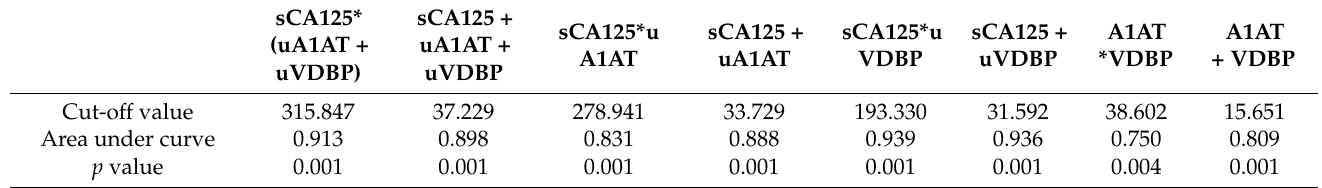
Table A6. The receiver operating characteristic (ROC) curve analysis of different combined exam- ined